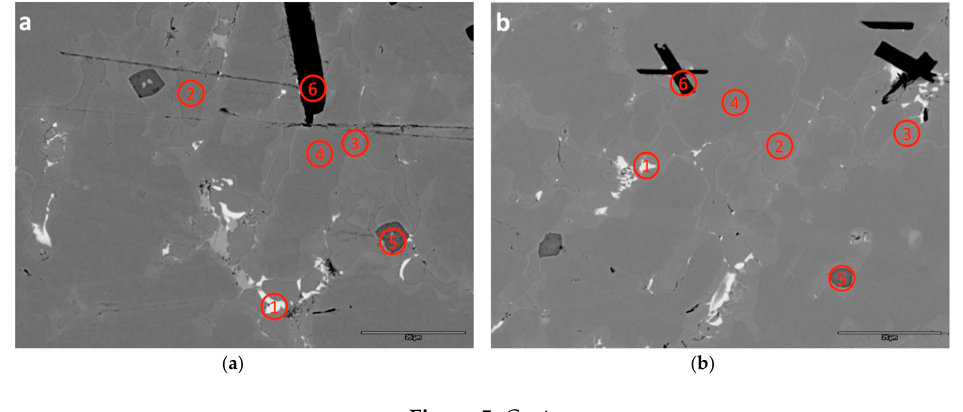
Figure 4. Evolutions of the C14, C15, TiNi, and V 3 B 2 phase abundances vs. alloy